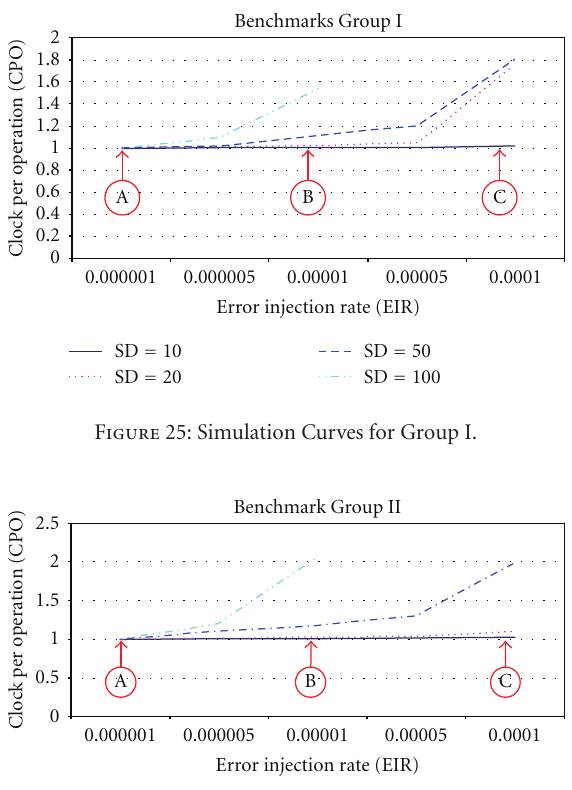
Figure 22: Results for 2 bit error injection.